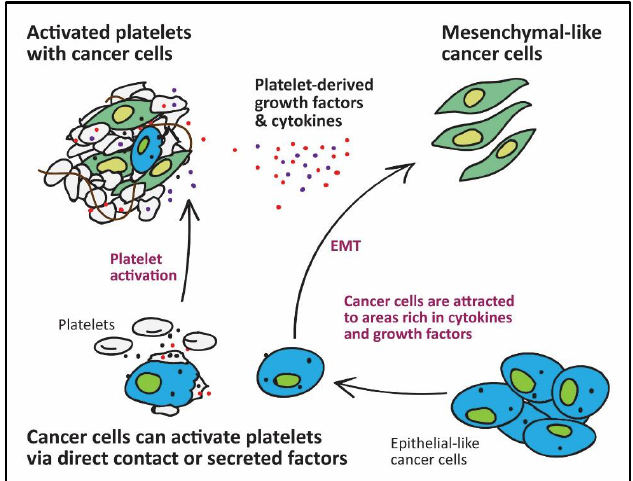
Figure 1. Platelets in Metastasis: Cancer cells can activate platelets. Activated platelets secrete growth factors and chemokines to attract other cancer cells to areas rich in survival factors. Platelet TGFβ1 induces EMT in cancer cells, which are characterised by an elongated shape and improved metastatic ability.